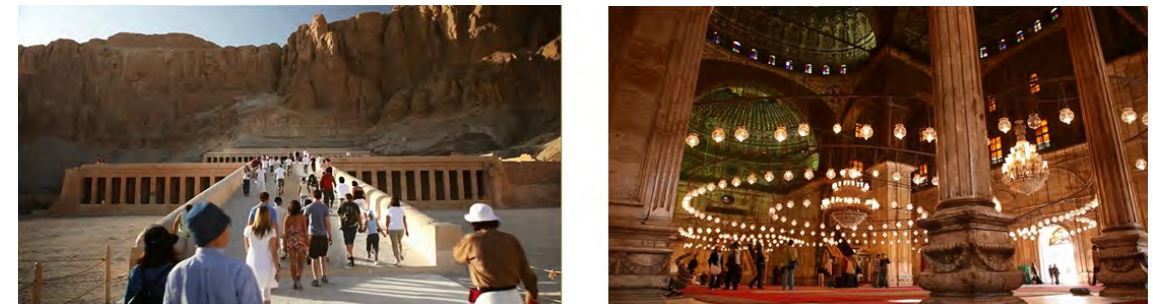
Figure 15. Historical places (hatshepsut temple – Muhammad Ali mosque ) , (New Egypt Old Friends, 2016) Brand city life